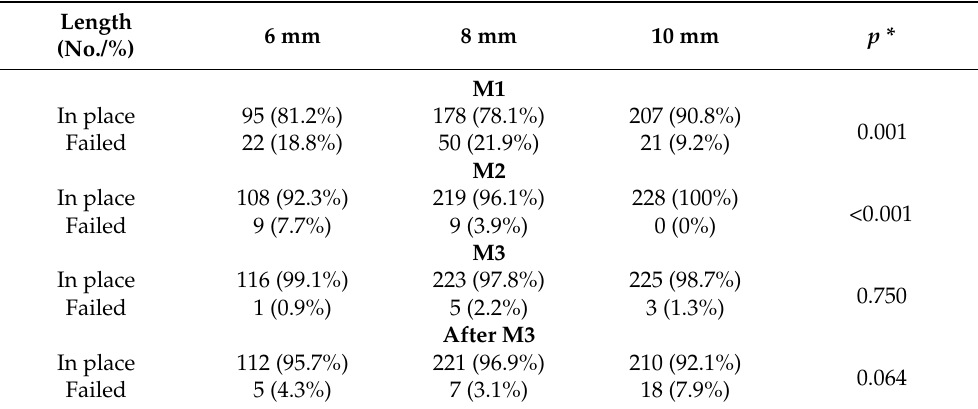
Table 7. Distribution of the mini-implants according to implant length and the rejection rate in M1, M2, M3 and after